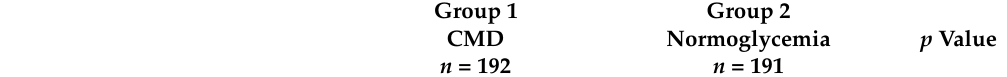
Table 2. Preoperative laboratory and instrumental